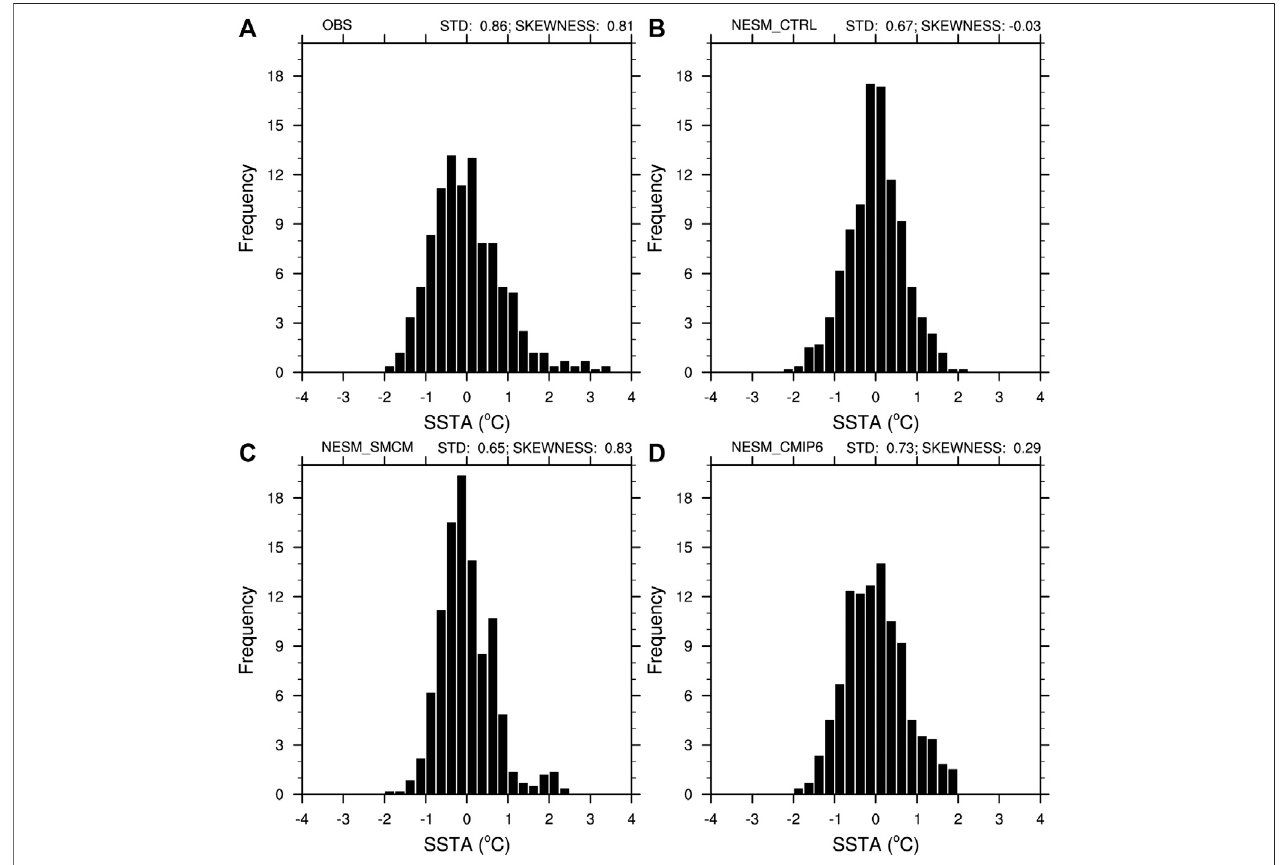
FIGURE 6 | Distribution histograms of the monthly Niño-3 SST anomalies: (A) observations, (B) NESM_CTRL, (C) NESM_SMCM, and (D) NESM_CMIP6. The width of the bin was 0.25 ° C.